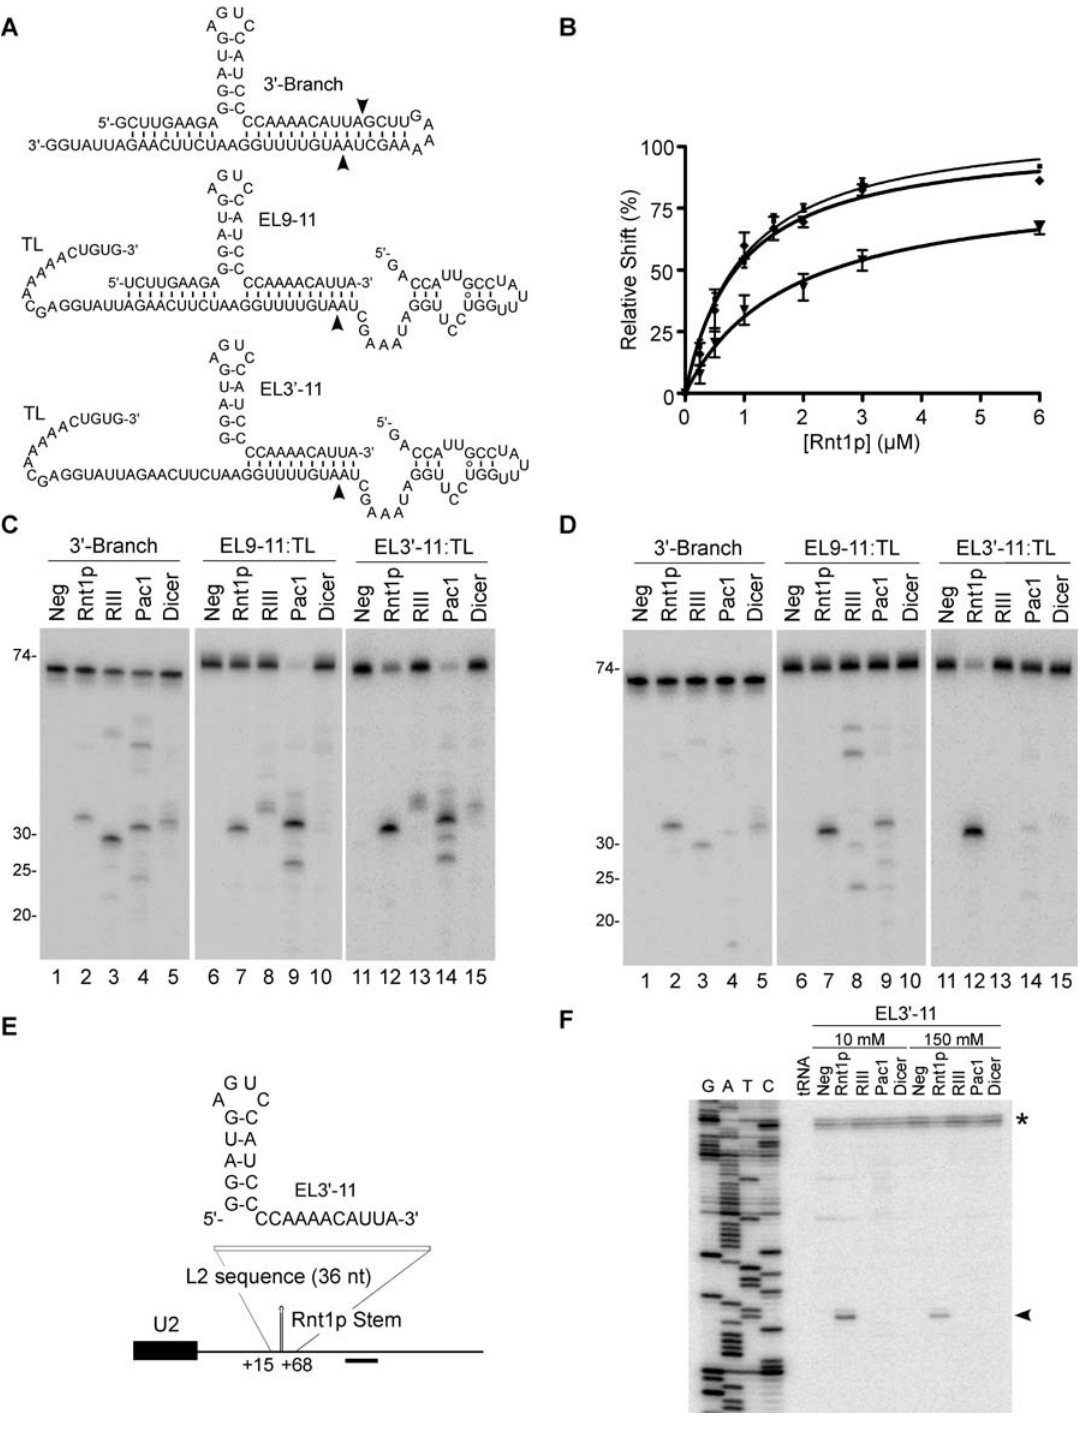
Figure 3. Comparison between inter- and intra-molecular RNA cleavage by different RNase IIIs. (A) Illustration of the different substrates used in C and D. 3 9 -Branch indicates a substrate allowing intramolecular cleavage by Rnt1p. EL3 9 -11 and EL9-11 indicate respectively a guide RNA with a single or two target complementary extensions. The target is indicated by TL. The arrowheads indicate the position of the observed cleavage by Rnt1p. (B) Quantitative analysis of RNA binding to Rnt1p. Increasing concentrations of Rnt1p (0.25 to 6 m M) were incubated with 3 fmol of 3 9 -Branch ( u ), EL9-11:TL ( s ) and EL3 9 - 11:TL ( t ) and the binding percentage (%) was plotted against the protein concentration. The curve fits were obtained using the Graph Pad Prism 4.0 program. Each data point is an average of four experiments. The target RNA in the trans reactions and the cis RNA were 5 9 -end labeled and incubated with members of the RNase III family. Rnt1p, bacterial RNase III (RIII), Pac1 and human Dicer were incubated in RNA excess under a 10 mM (C) or 150 mM (D) KCl. The position of the RNA ladder is shown on the left. (E) Sketch of a 36 nt fragment containing sequences complementary to EL3 9 -11 inserted into a U2 3 9 -end flanking region to replace a canonical Rnt1p substrate. The position of the oligonucleotide used for primer extension is indicated. (F) Mapping the cleavage of the U2 3 9 -end region with RNase IIIs. Yeast total RNA (20 m g) from YHM111-U2L2 was incubated with EL3 9 -11 and RNase IIIs in 10 and 150 mM KCl. A primer complementary to the 3 9 -flanking sequence of U2 snRNA was extended in all cleavage reactions. The reference DNA sequence is shown on the left. The arrowhead indicates a specific cleavage product. The asterisk indicates a secondary structure at the mature U2 3 9 -end. doi:10.1371/journal.pone.0000472.g003 PLoS ONE |